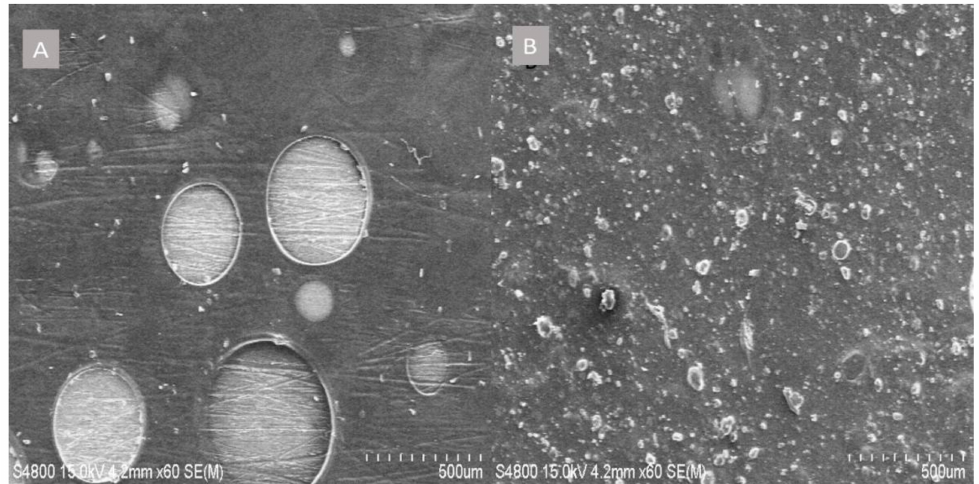
Figure 3. SEM micrograph of ( A ) chitosan and ( B ) CS-ZnHNTs-GS deposits.